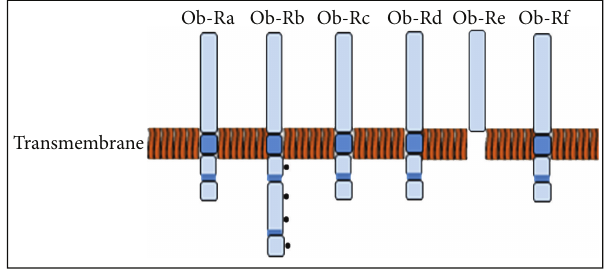
Figure 2: Structure of leptin receptor isoforms—6 different iso- forms of the leptin receptor Ob-R (a–f). Extracellular ligand-bind domains of receptor isoforms are identical but they differ at the C-